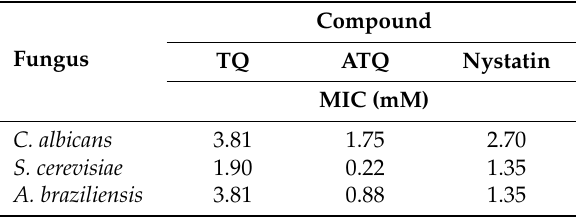
Table 2. In vitro antifungal activity presented as minimum inhibitory concentration (MIC/mM) values of investigated compounds.